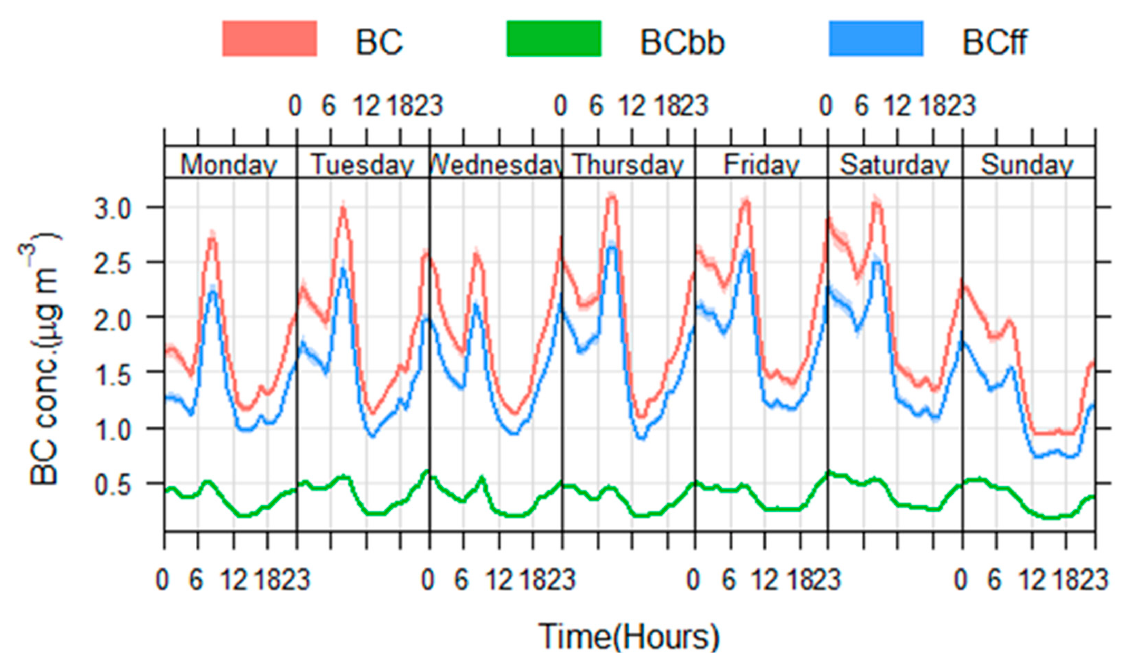
Figure 4. Mean day ‐ of ‐ the ‐ week diurnal variations in concentrations of BC (red line), BC bb (green line), and BC ff (blue line). Figure 4. Mean day-of-the-week diurnal variations in concentrations of BC (red line), BC